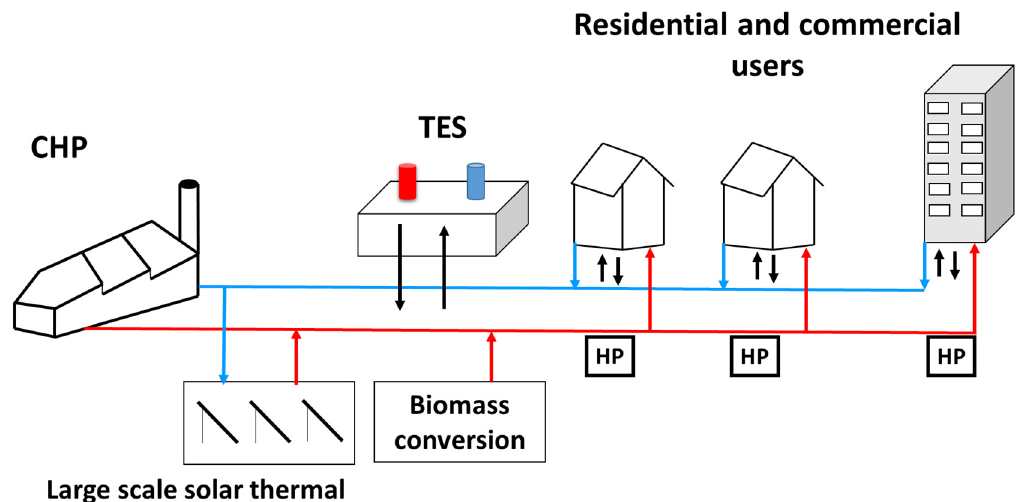
Figure 4. Fifth-generation DH system supply line is red while return line is blue. Arrows represent energy exchange. HP represents heat pumps.